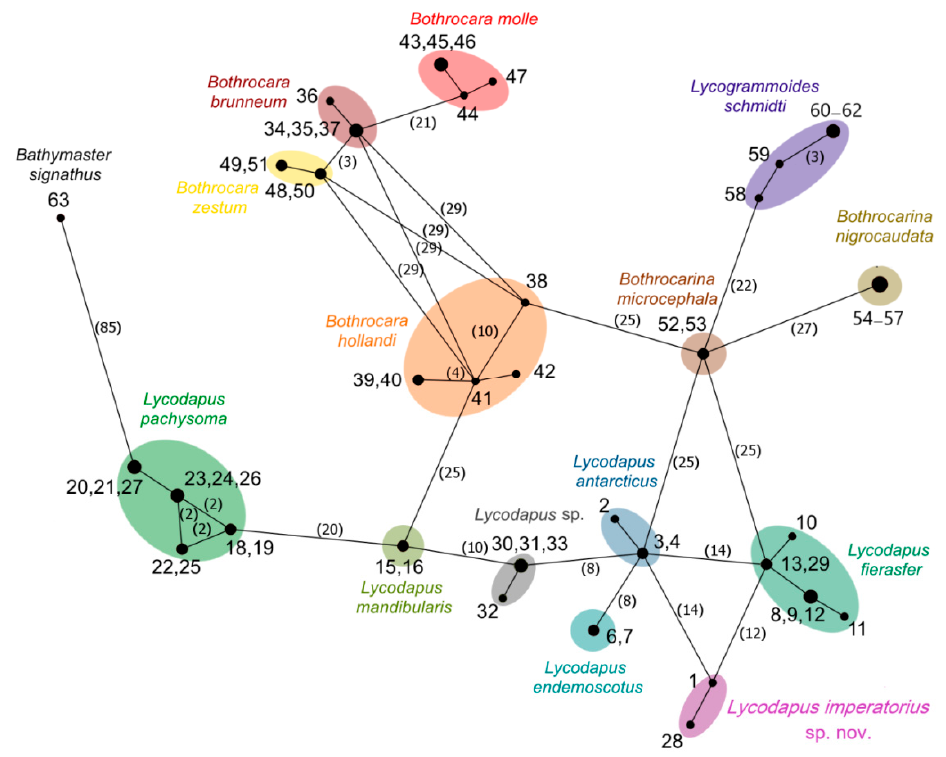
Figure 3. Phylogenetic relationships of Lycodapus imperatorius sp. nov. and allied species by COI mtDNA sequences. Numbers indicate haplotypes (see Table 1 for explanation), numbers of substitutions are given in brackets, size of black circles correspond to number of specimens.